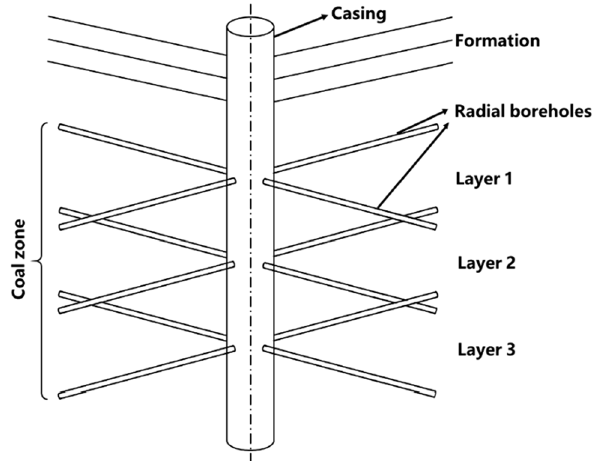
Fig. 9 Schematic of radial boreholes in multiple coal seams, after Dickinson et al.